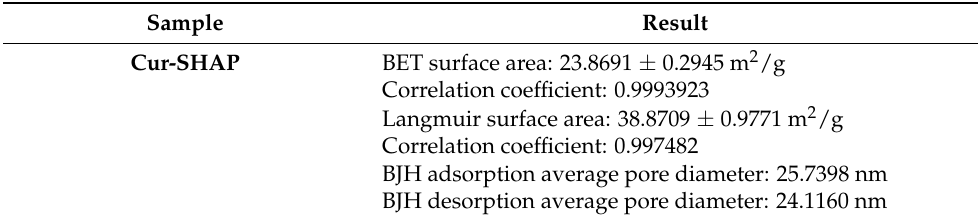
Table 1. BET surface area and the porosity of Cur-SHAP. The BET surface area was 23.8691 m 2 /g while the Langmuir surface area was 38.8709 m 2 /g.